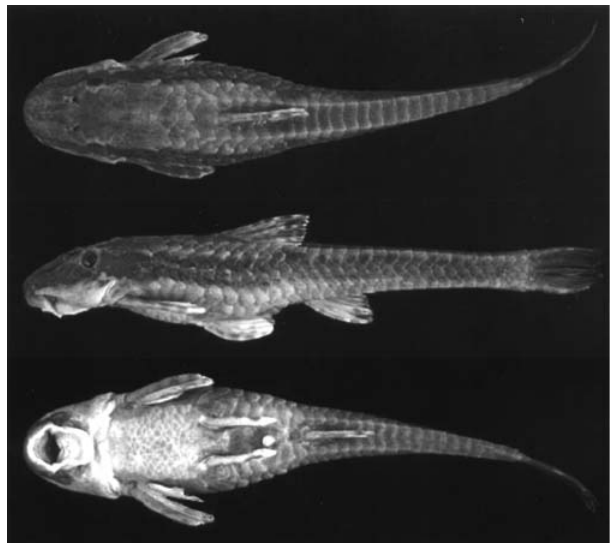
Fig. 3 . Pseudotocinclus parahybae , holotype, MZUSP 49122, 62.9 mm SL; tributary of ribeirão Grande, Fazenda